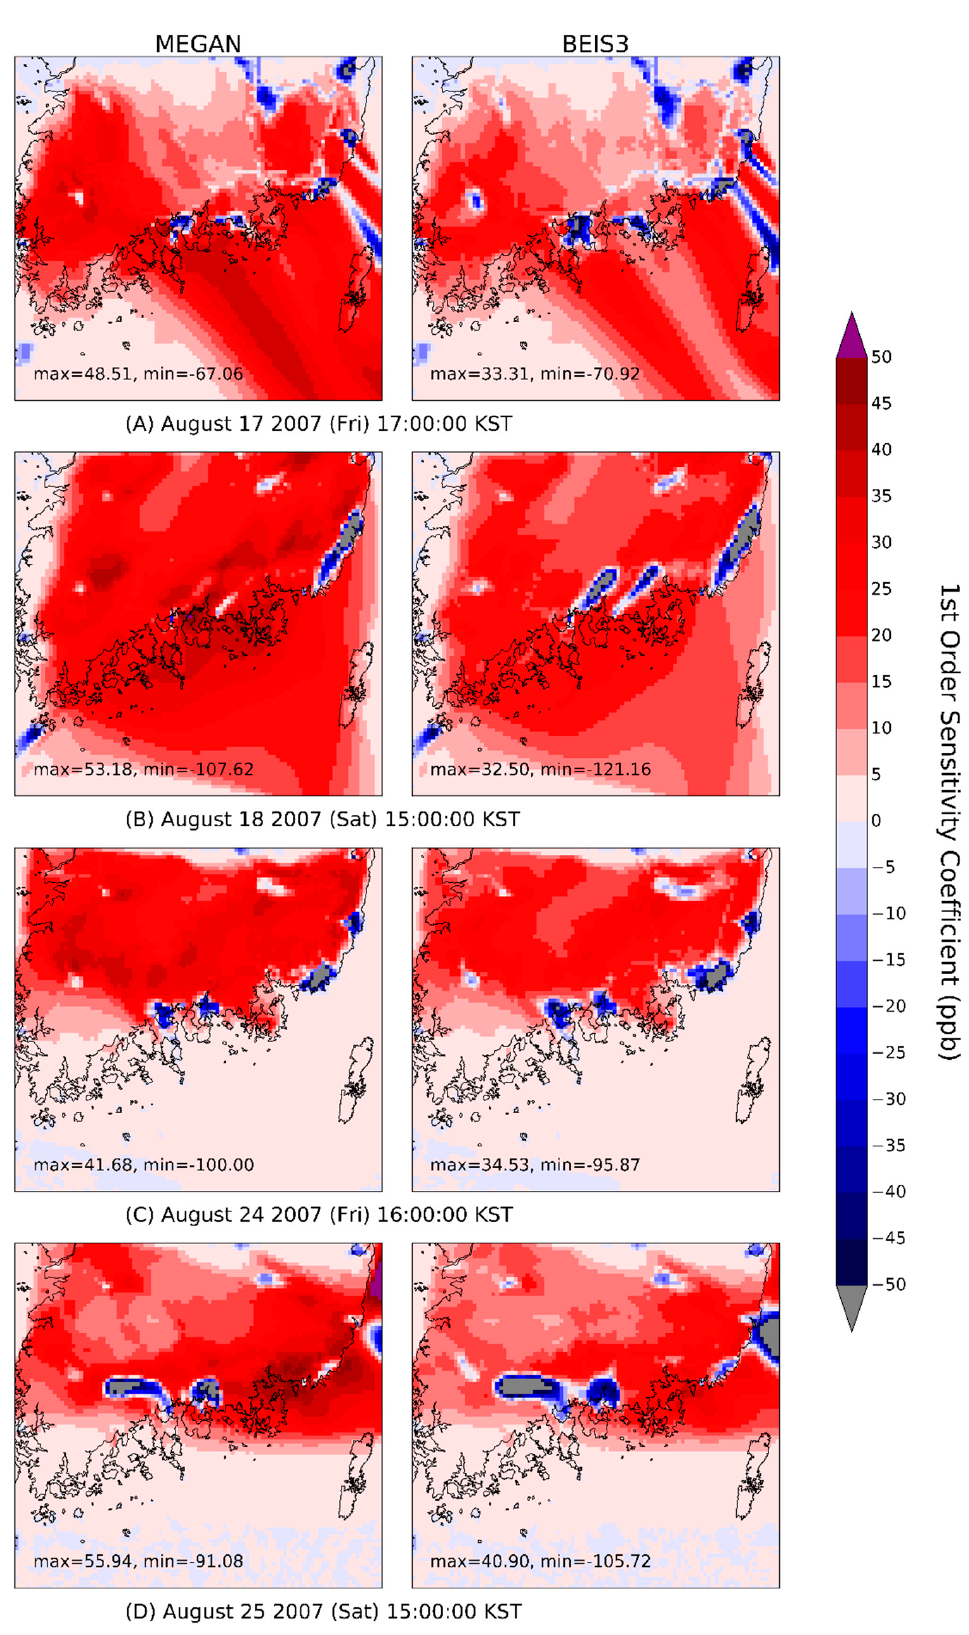
Figure 11. The first-order sensitivity coefficients to changes in NO x at ( A ) 5 PM on 17 August, ( B ) 3 PM on 18 August 2007 ( C ) 4 PM on 24 August, and ( D ) 3 PM on 25 August.